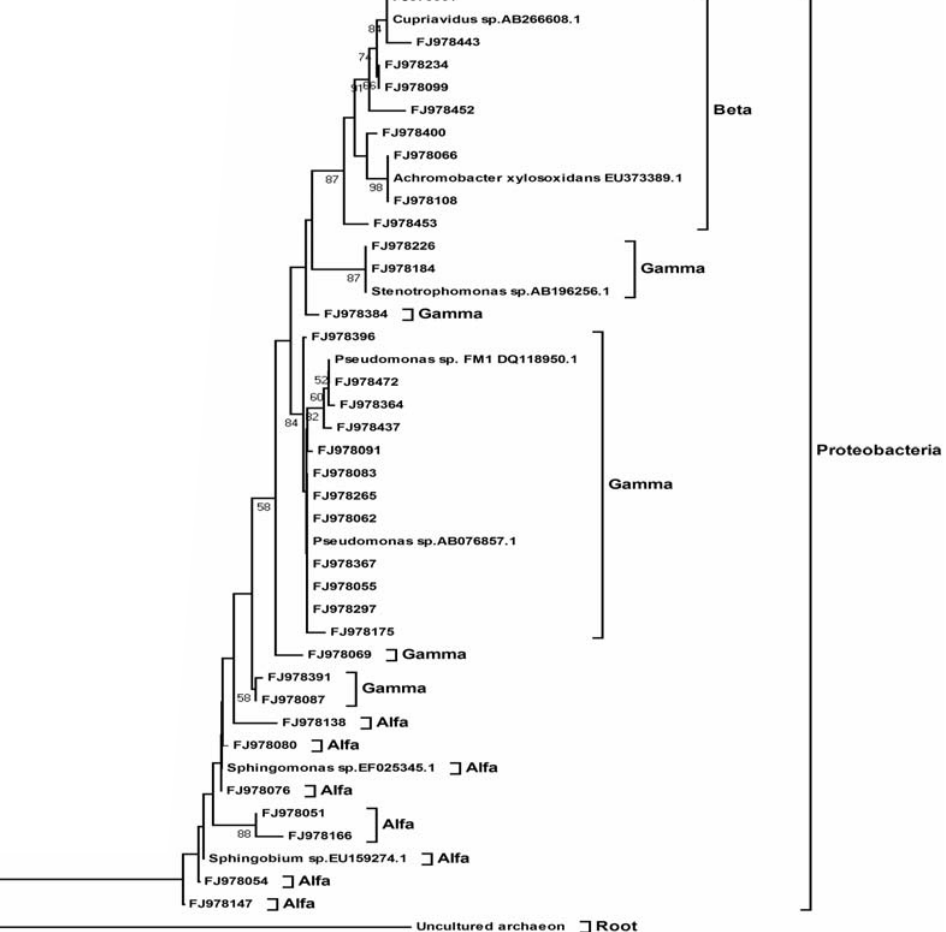
Figure 1. Phylogenetic tree based on the partial sequences of 16S rDNA from the consortium, generated by the MEGA program, version 4. The distance matrix was calculated using the “Neighbor-Joining” algorithm and the nucleotide substitution method “Kimura 2-P”, with a “bootstrap” of 1000